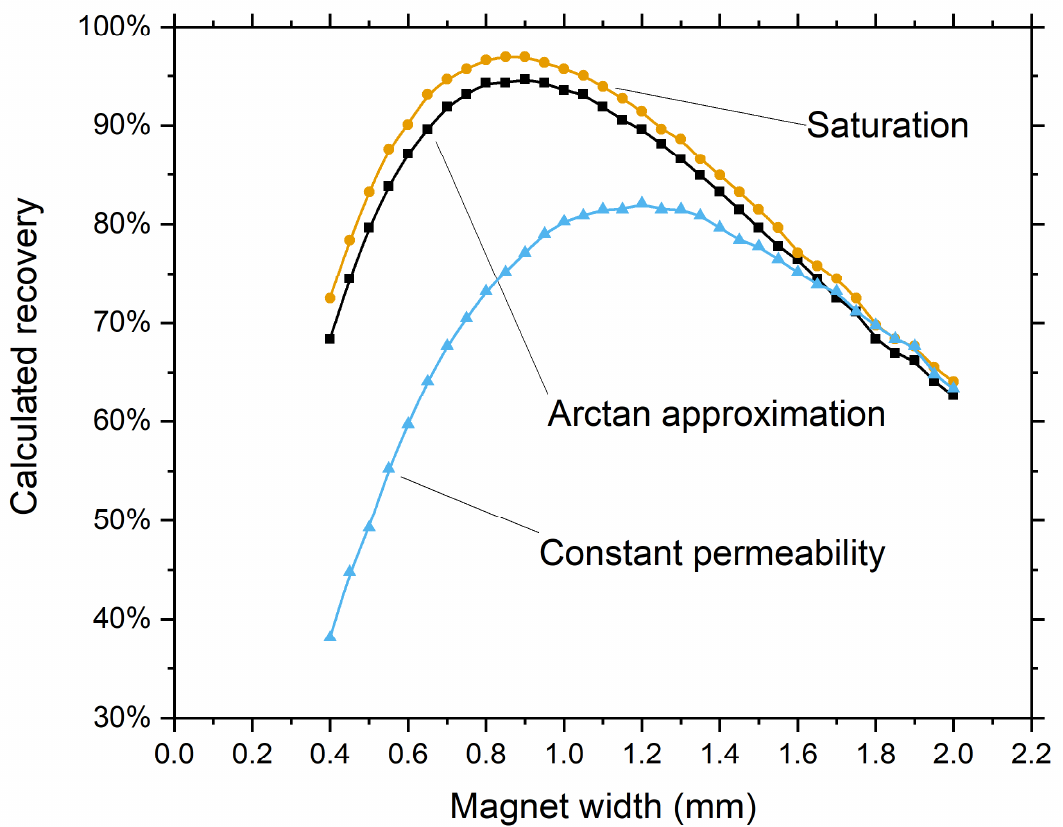
Figure 6. Calculated recovery versus magnet width for a 1.5-mm-high Halbach array using different approximations, showing a similar optimal magnet width for the assumption of saturation and the arctangent function but a clearly deviating optimum when assuming a constant permeability.